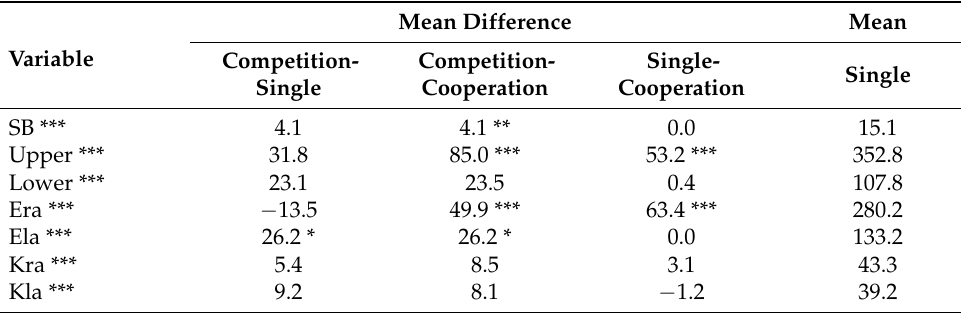
Table 7. Multiple comparison of effects of gameplay modes on Kinect data.